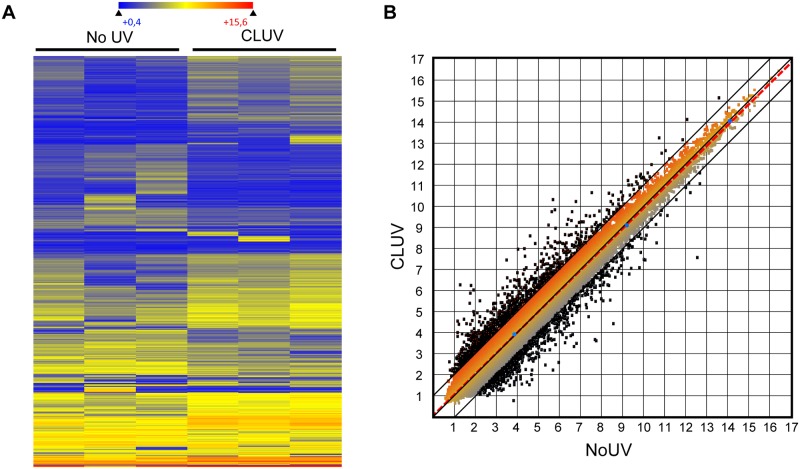
CLUV treatment induces transcriptomic changes.After NHDF were subjected or not to the CLUV treatment, total RNA was extracted to analyze gene profiling. For this experiment, the CLUV treatment is performed using 100 J/m2 of UVB instead of 75 J/m2. The experiment was performed in triplicate using 3 different NHDF strains. (A) Heatmap depicting the significantly deregulated genes in CLUV treated NHDF and un-irradiated controls. This experiment was performed in 3 different NHDF strains, and the heatmap clearly shows the reproducibility of CLUV-induced changes between strains. The color scale is based on the log2 expression level values. Hierarchical clustering was performed on rows based on the Euclidian distance. Genes indicated in dark blue correspond to those whose expression is very low, whereas highly expressed genes are shown in red. (B) Scatter plot of log2 signal intensity for 60 000 targets covering the entire human transcriptome. The signal for CLUV cells at 0 h (y-axis) is plotted against un-irradiated cells (Control, No UVB) (x-axis). All the >2-fold deregulated genes between the 2 conditions are represented by black dots. The 3 blue points are 3 controls (B2M, TUBB, GOLGA1). The transcription level of those genes is known to be stable, independent of cell type and condition [39].